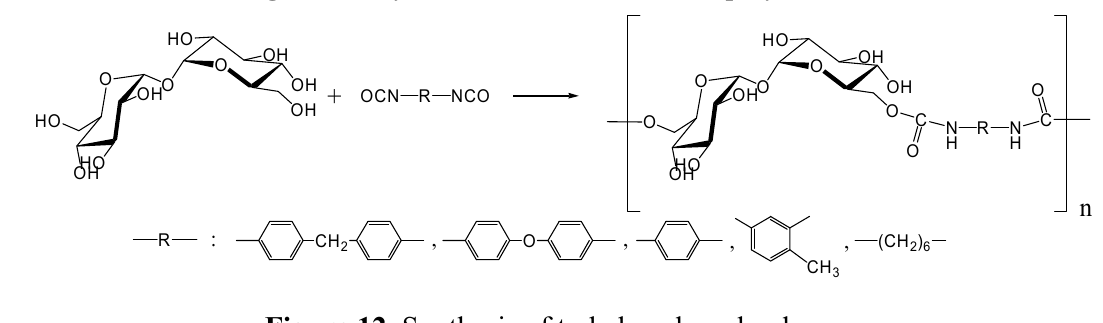
Figure 11. Synthesis of trehalose-based polyurethane.